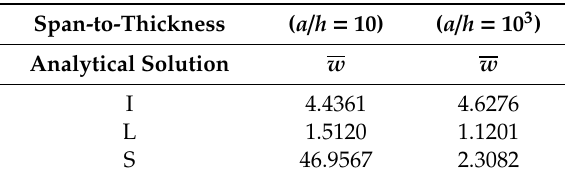
Table 4. Analytical solutions for the non-dimensional maximum deflection under uniform pressure square thick ( a/h = 10) and very thin ( a/h = 10 3 ) plates, simply supported on all edges.